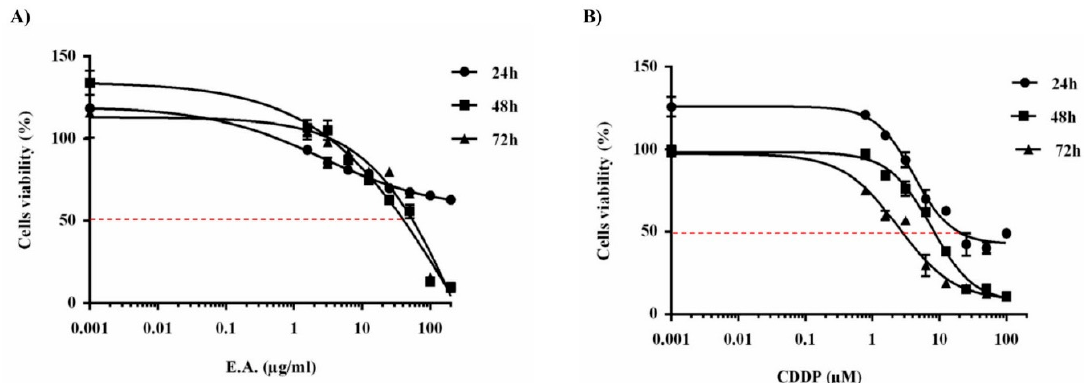
Figure 1. Concentration ‐ dependent inhibition of breast cancer cell viability by E.A. extract. After 24 h of culture, breast cancer cells 4T1 were exposed with increasing concentrations of ( A ) E.A. (from 0 to 100 µ g / mL) or ( B ) cisplatin (CDDP) (0 to 100 µ M) at 37 ◦ C for 24 h ( • ), 48 h ( (cid:4) ), and 72 h ( (cid:78) ). percentage of cell viability was determined by crystal violet assay. Results are expressed as percentage of control (mean ± standard deviation of three independent experiments with n = 6). Table 2. IC 50 values determined from cell viability assays for E.A. and CDDP on the 4T1 breast cancer cells at the different times of treatment.